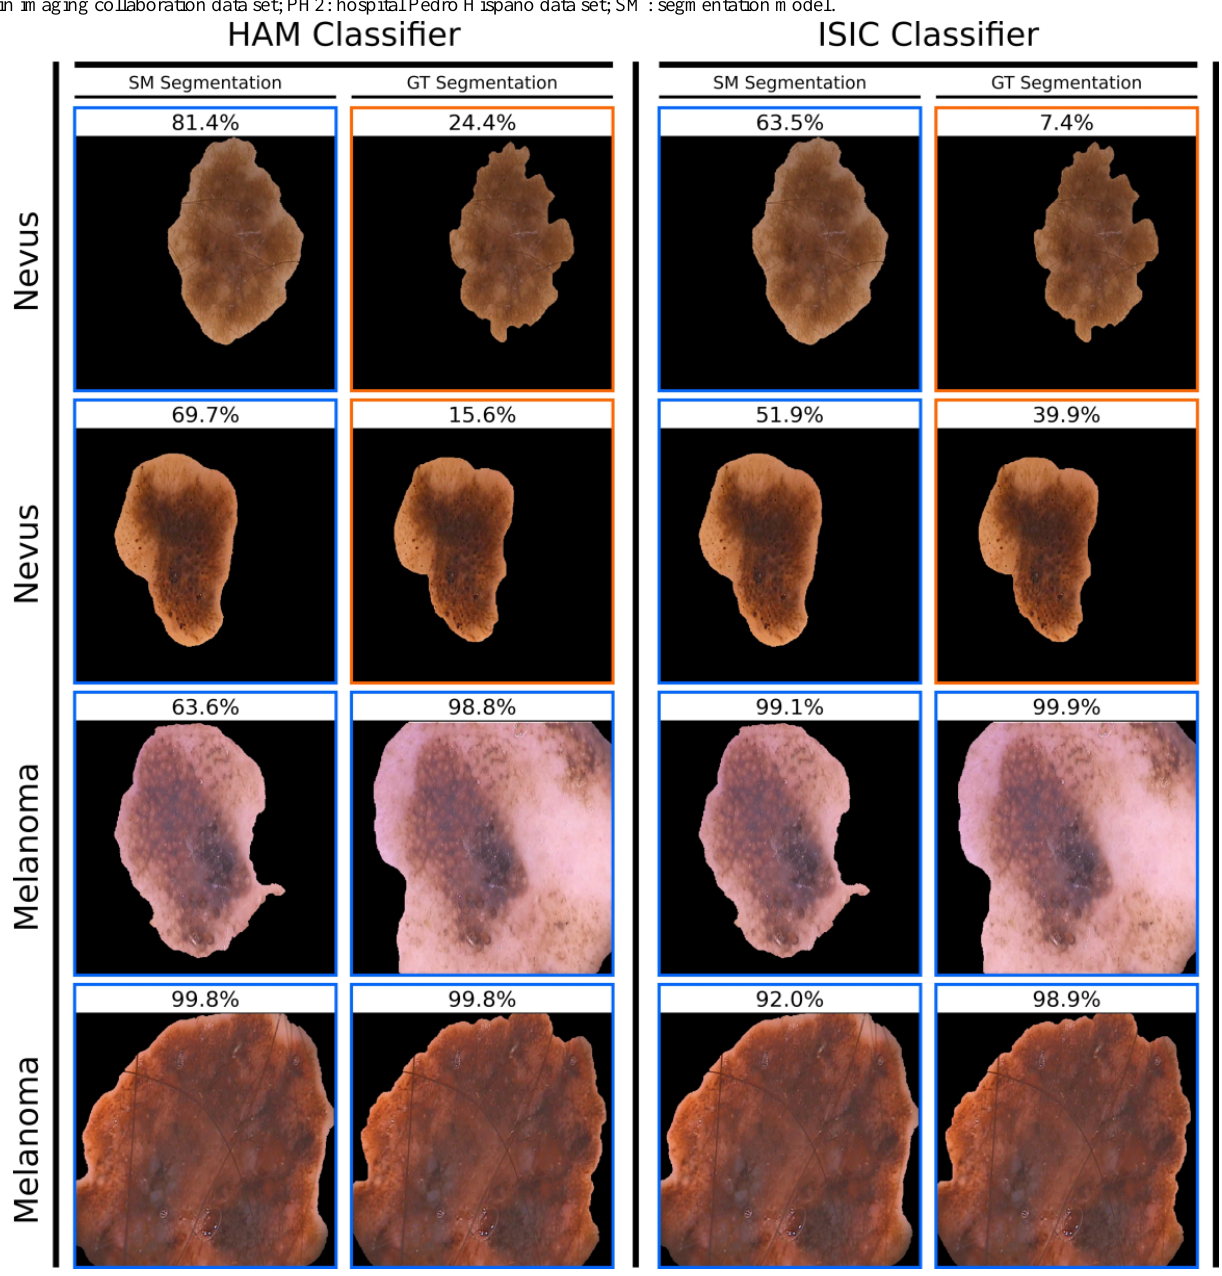
Figure 4. Exemplary predictions of a classifier trained on unsegmented HAM (left) and ISIC (right) images and evaluated on PH2 images with different segmentation masks. PH2 images in the SM column were segmented using the segmentation model. PH2 images in the GT column were segmented using dermatologist-generated ground truth segmentation masks. The target class (ground truth) for each lesion is displayed to the left, with the classifier’s output probability for the target class on top. An output probability larger than 50% corresponds to a correct classification, which is also indicated by a blue frame, whereas an orange frame denotes an incorrect classification. GT: ground truth; HAM: human against machine data set; ISIC: